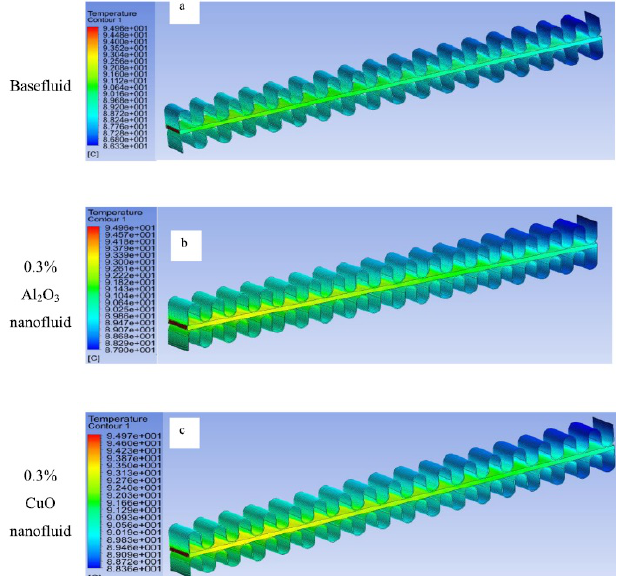
Figure 7. Temperature and streamline profiles of a coolant at 6 L/min in a car radiator: ( a ) base fluid; ( b ) Al 2 O 3 nanofluid ( ϕ = 0.3 vol.%); ( c ) CuO nanofluid ( ϕ = 0.3 vol.%). Results obtained by Tijani and bin Sudirman [21] for a 50:50 EG-water mixture and reproduced with permission from